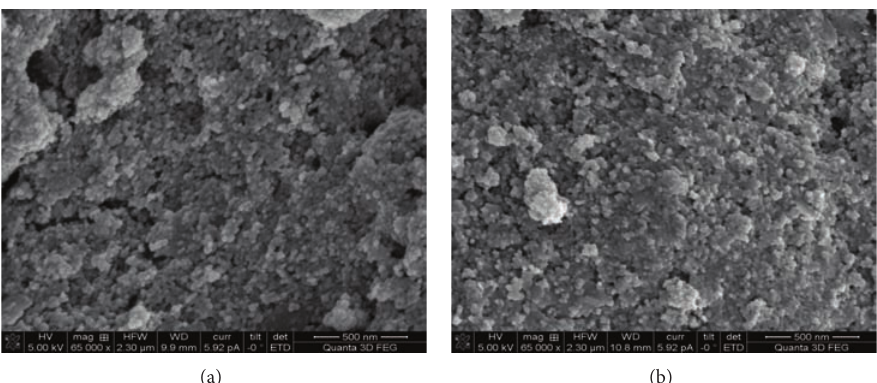
Figure 14: SEM image showing the surface morphology of ((a), left) RDS and ((b), right) CS NiO layer ( 𝑙 = 2-3 𝜇 m) deposited onto ITO via sintering of nanoparticles with average diameter of 40nm.